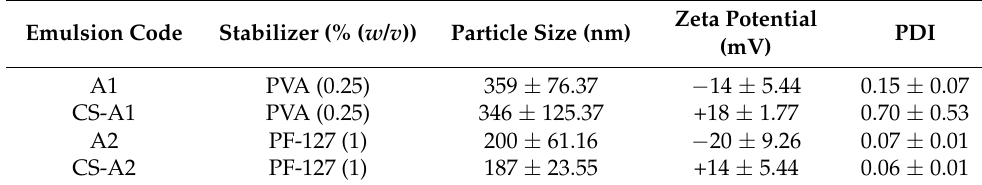
Table 2. Particle size, zeta potential, PDI and % encapsulation efficiency of the NPs from screening experiments. Particle size is the representation of the diameter of the particle (nm). Data = mean ± std ( n =